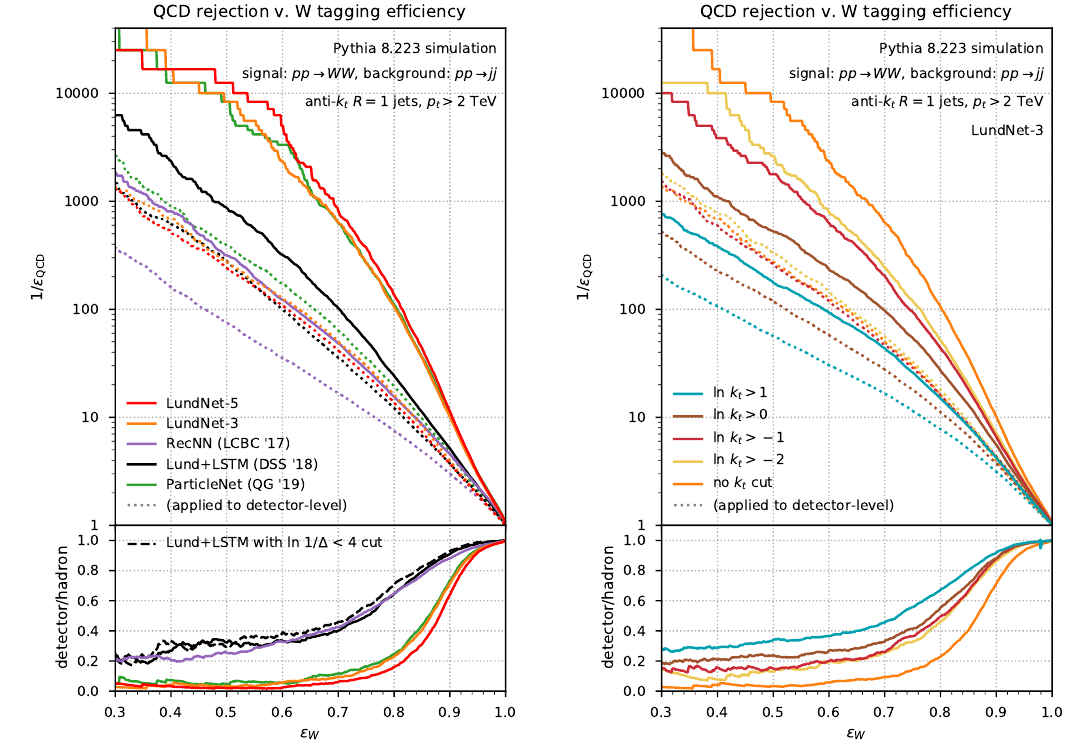
Figure 11 . Background rejection as a function of W tagging efficiency. Dotted lines indicate a W tagger applied on detector-level